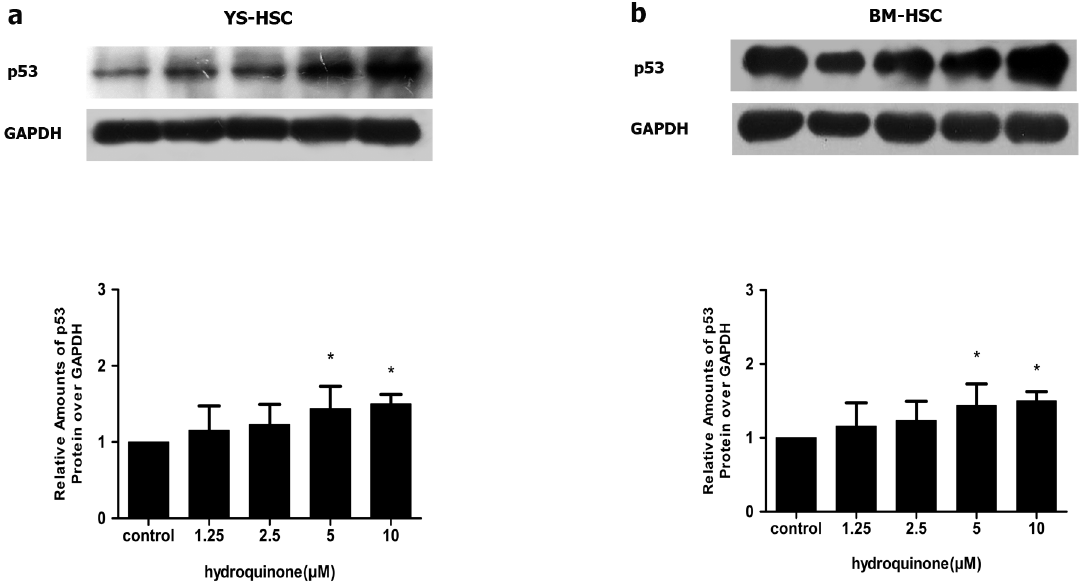
Figure 7. Effect of HQ on Cyp4f18 mRNA expression. Expression of Cyp4f18 mRNA in YS-HSC (a) and BM-HSC (b) was measured by quantitative real–time PCR. The relative expression of target genes was calculated using the 2 2 DD Ct method. Data represent means 6 SDs of at least three individual experiments (*, P , 0.05; **, P , 0.01; and # , P , 0.001; compared to control group values.).